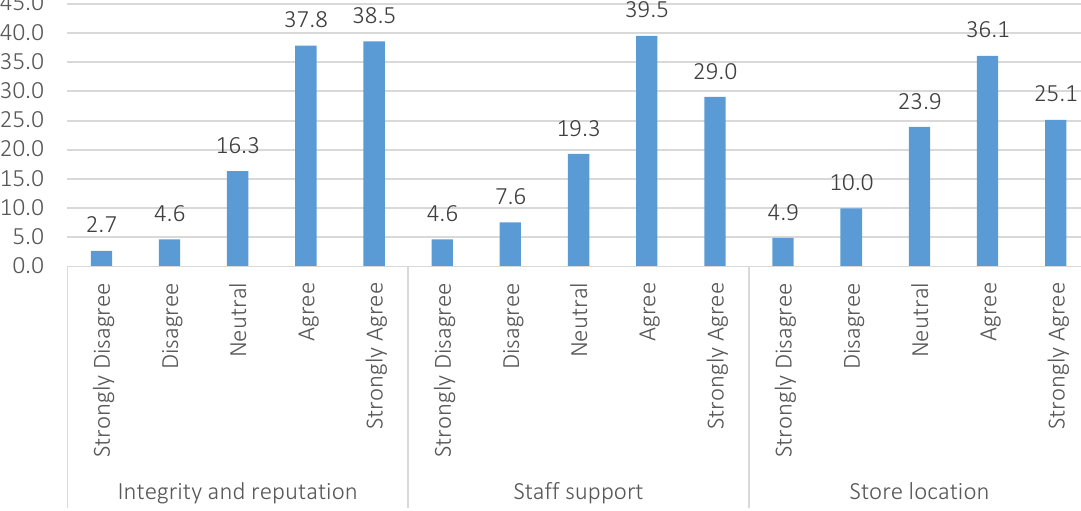
Figure 6. Background analysis based on integrity and reputation, staff support, and store